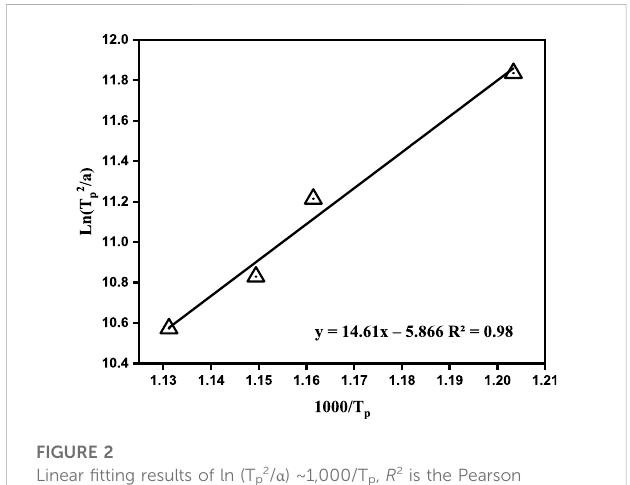
FIGURE 2 Linear fi tting results of ln (T p 2 / α ) ~1,000/T p , R 2 is the Pearson correlation coef fi